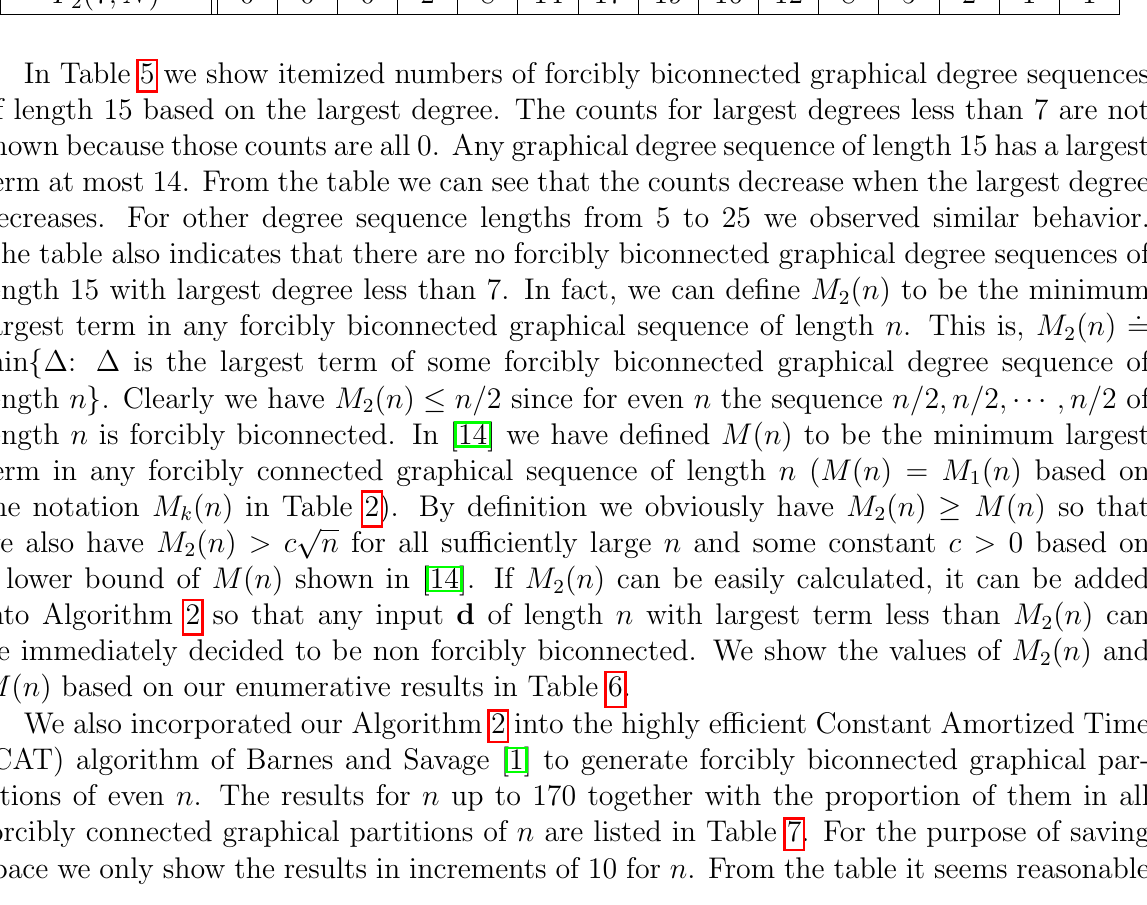
(7 , N )) and forcibly (row F 2